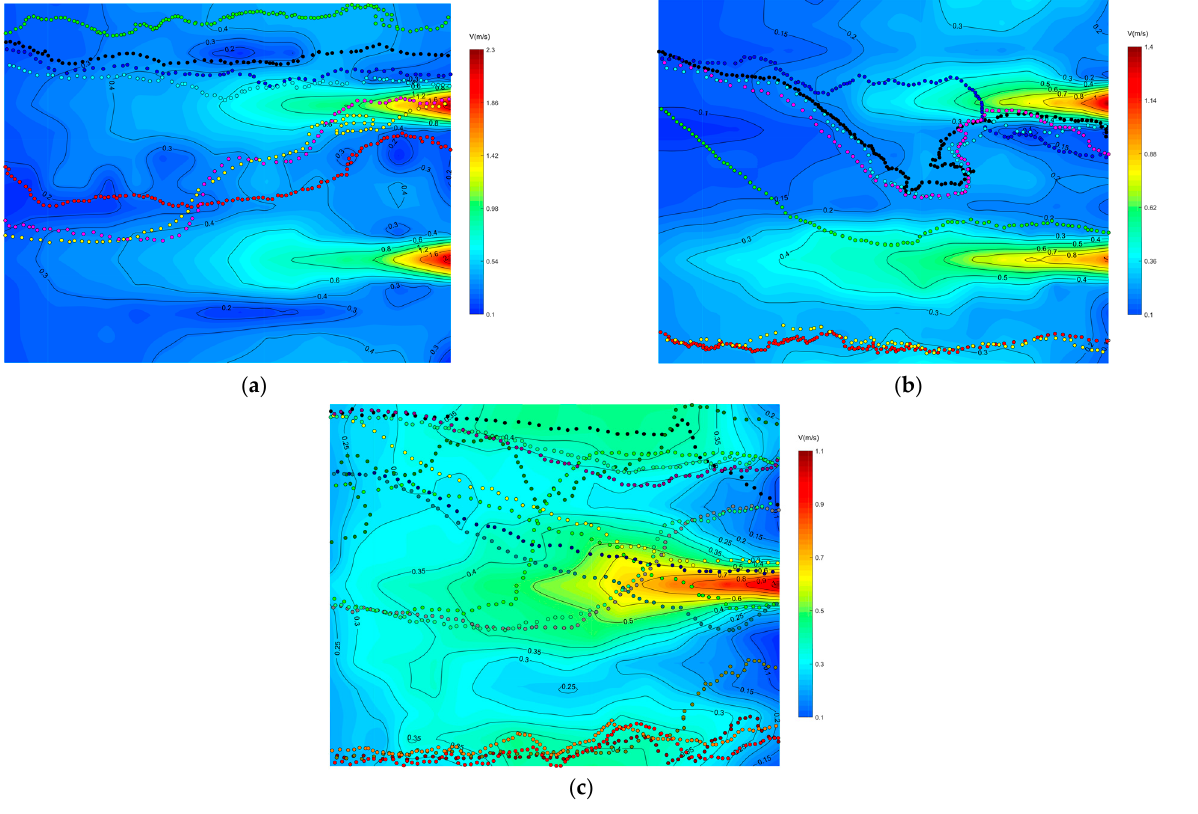
Figure 4. Swimming trajectory of some experimental fish in different water flow conditions. ( a ) Lateral symmetric bimodal outflow; ( b ) Lateral asymmetric bimodal outflow; ( c ) Single peak outflow.